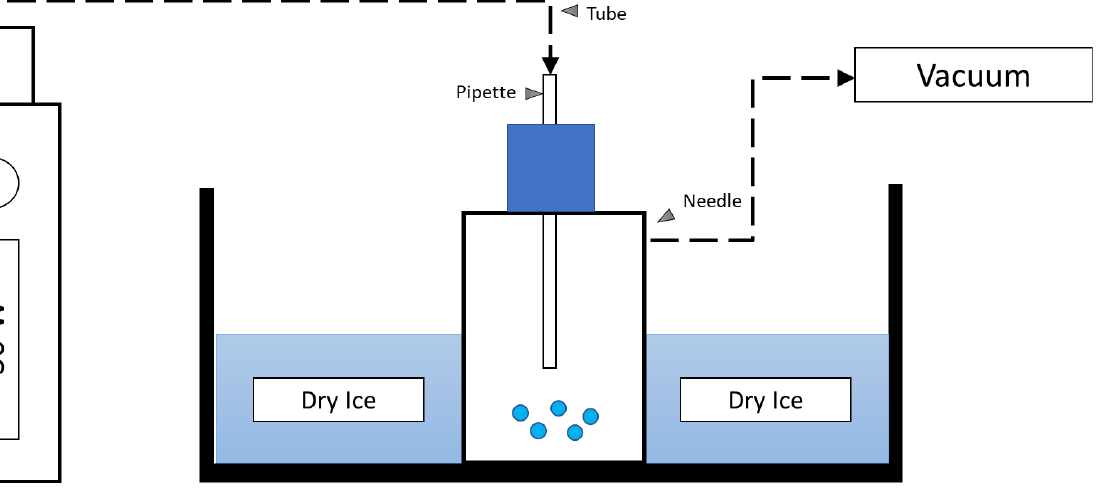
Figure 7. Experimental setup for e-cigarette aerosol condensate collection.